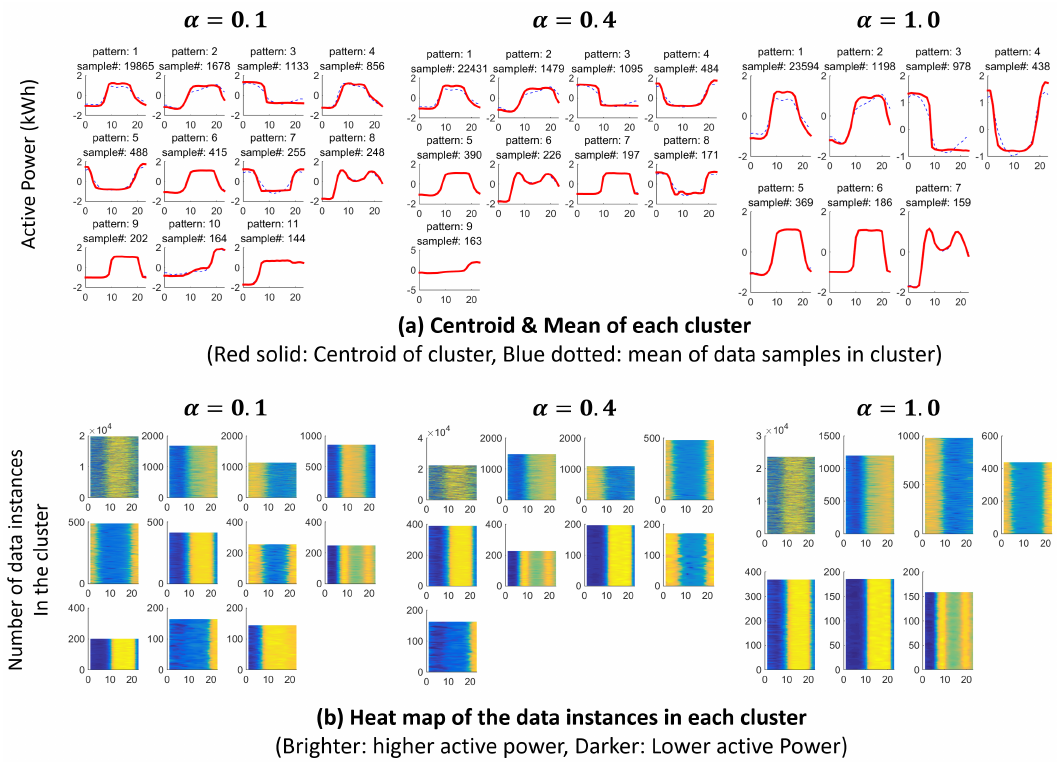
Figure 8. Clustering results of KEPCO data set with Euclidean distance.